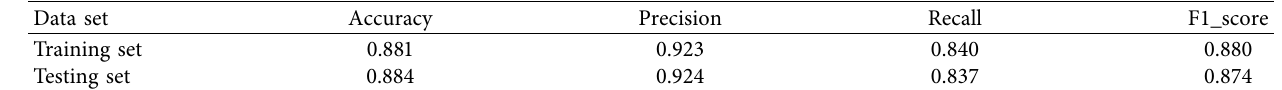
Figure 11: Comparison of ROC curves (a) before and (b) after k- means SMOTE. Table 3: Comparison results of different data sets.